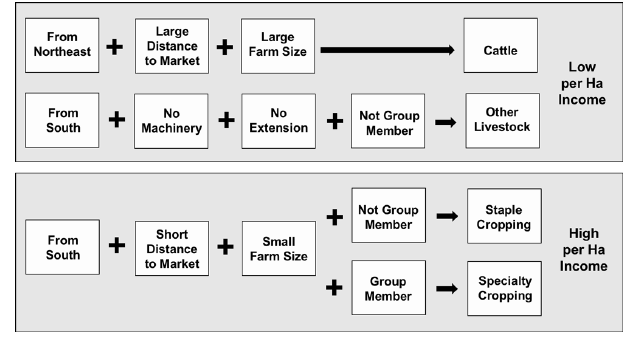
Fig. 4 . Land uses and their correlates. Selected significant results of the multinomial land use model are presented to demonstrate major differences in assets and attributes across households specializing in different land uses, i.e., 75% of their area is allocated to this land use. Cattle specialization is most common among households from the northeast and properties that are large and located farther away from markets. Properties specializing in noncattle livestock are characterized by a lack of machinery, extension, and membership in groups. Specialization in cropping is most common among households from the south and properties that are small and located closer to markets. Agricultural group membership differentiates households that pursue specialty cropping versus staple